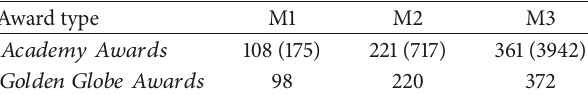
Table 3: The number of nominated movies in the MovieLens datasets . Both the Academy Awards and the Golden Globe Awards are considered. The numbers in brackets are the corresponding average numbers of ratings.